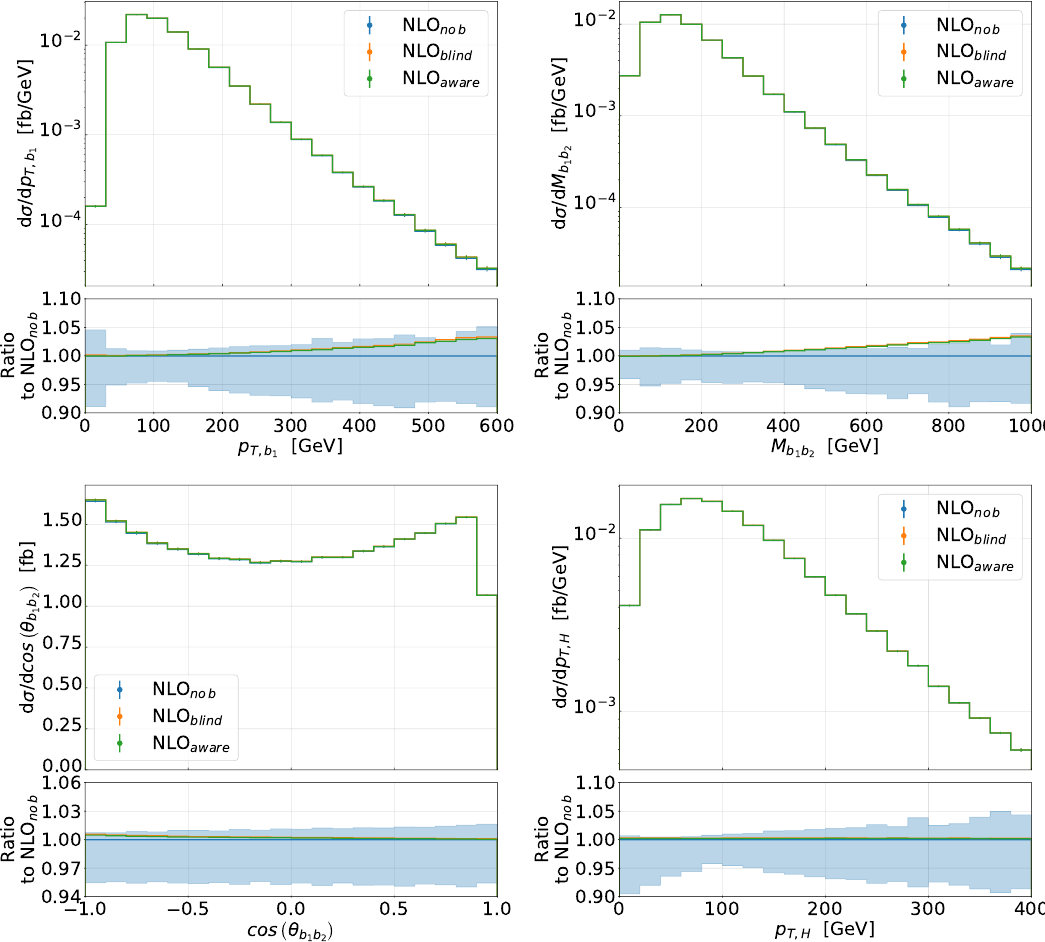
Figure 14 . Differential distributions at NLO QCD for the observables p T,b p T,H for the pp → e + ν e µ − ¯ ν µ b ¯ b H process at the LHC with µ 0 = H T / 2 and NNPDF3.1 PDF set. Theoretical predictions are shown without and with initial state bottom quark contributions in the charge-aware and charge-blind scheme. Also given are Monte Carlo integration errors. The lower panels display ratio to the case without the bottom- initiated contribution together with its scale